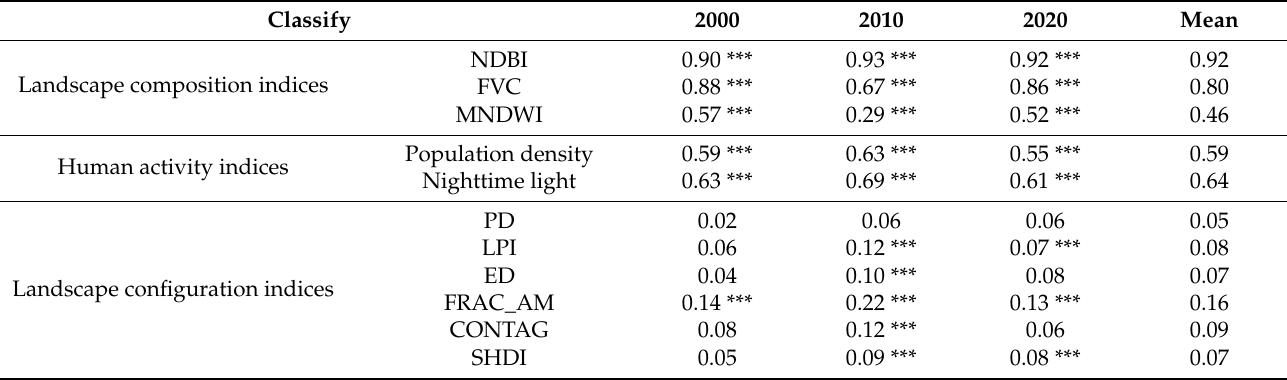
Table 7. Results of the landscape-level factor